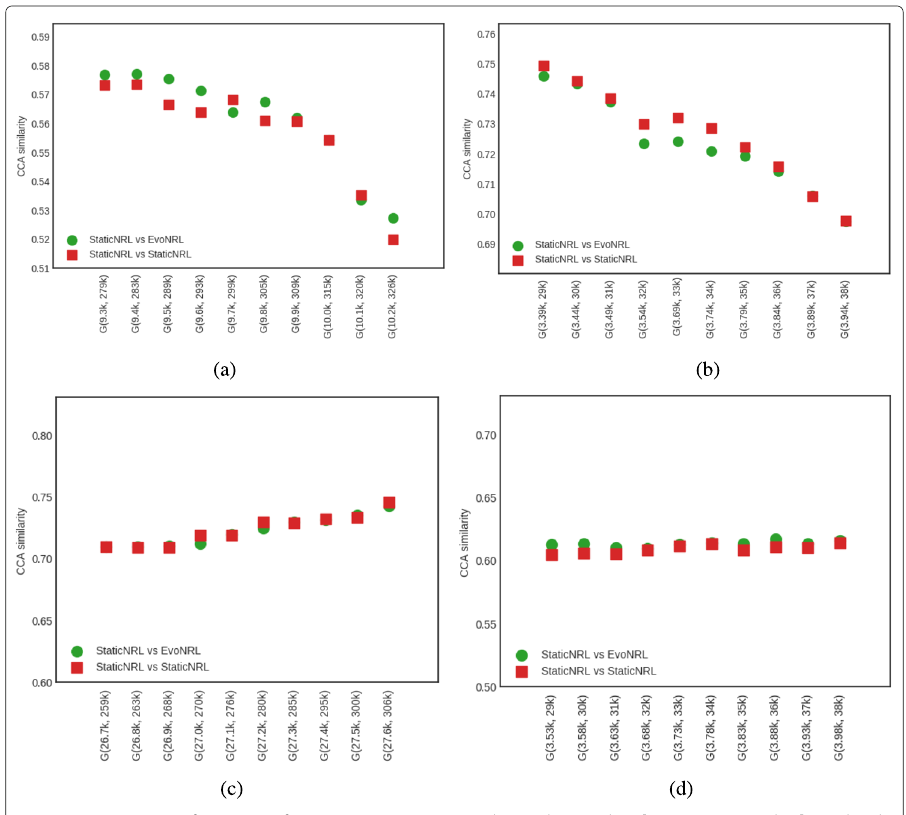
Fig. 10 Accuracy performance of E VO NRL — removing nodes. a BlogCatalog, b PPI, c Cit-HepTh, d Facebook